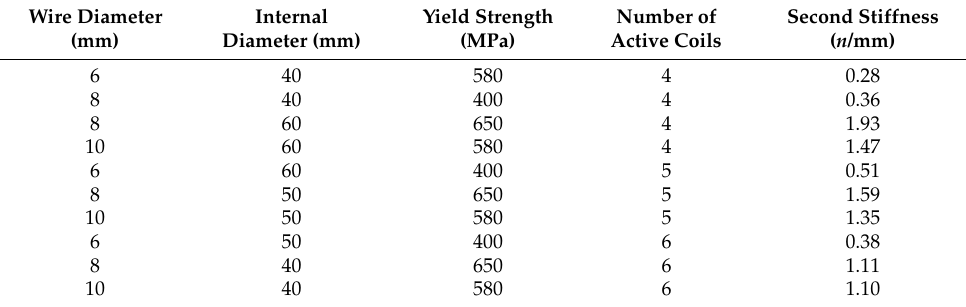
Table 4. Input and output patterns of ANN3.